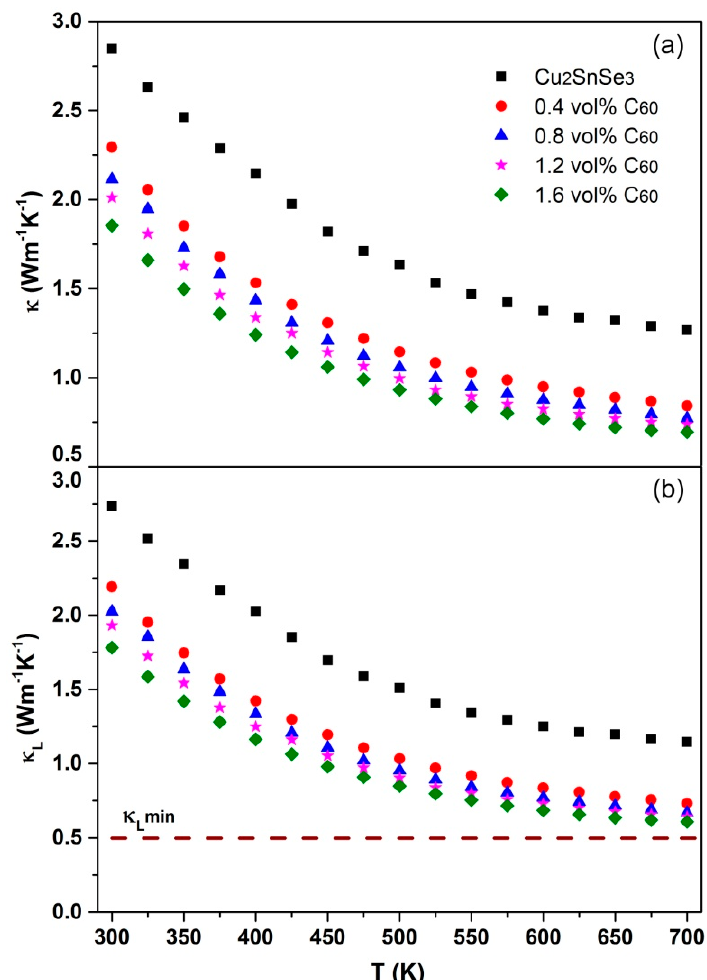
Figure 10. ( a ) Temperature dependence of total thermal conductivity ( κ ) of C 60 /Cu 2 SnSe 3 composites; ( b ) temperature dependence of lattice thermal conductivity ( κ L ) of C 60 /Cu 2 SnSe 3 composites.